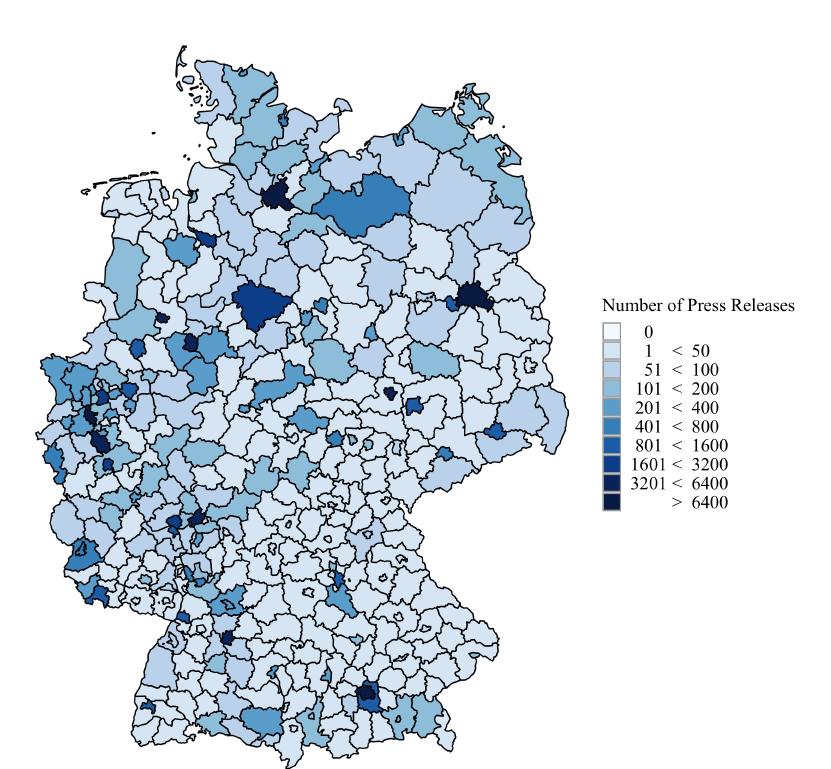
Figure 1: Spatial distribution of press